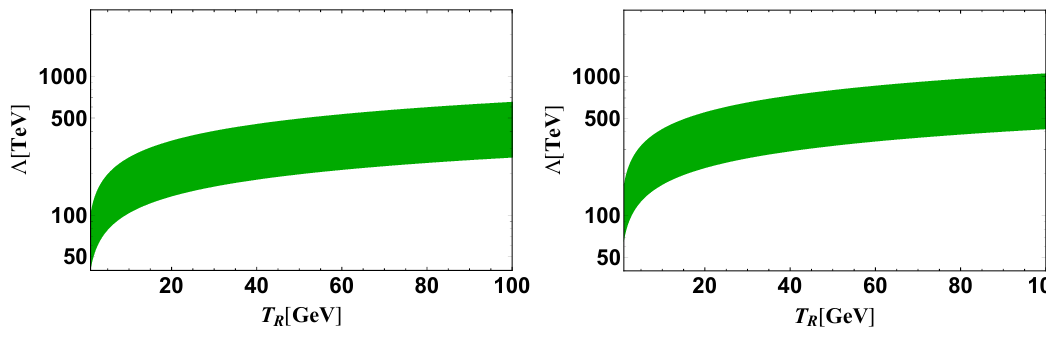
Figure 1 . The analytical upper bound on (cid:3) [ TeV], the scale of the dominant dimension nine inter- action, to get correct amount of the baryon asymmetry as a function of the reheating temperature. We take C = 2 8 (left) and C = 5 (cid:2) 10 4 (right). In both (cid:12)gures, B(cid:24) CP = 1 is taken for simplicity, and the range corresponds to the variation of C 0 = [0 : 3 ;